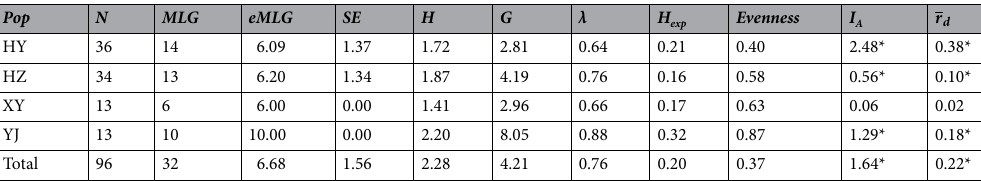
Table 5. Genotypic diversity statistics of four populations in Guangdong Province for P. polysora . N is the number of isolates in each population. MLG is the number of the multilocus genotypes observed. eMLG is